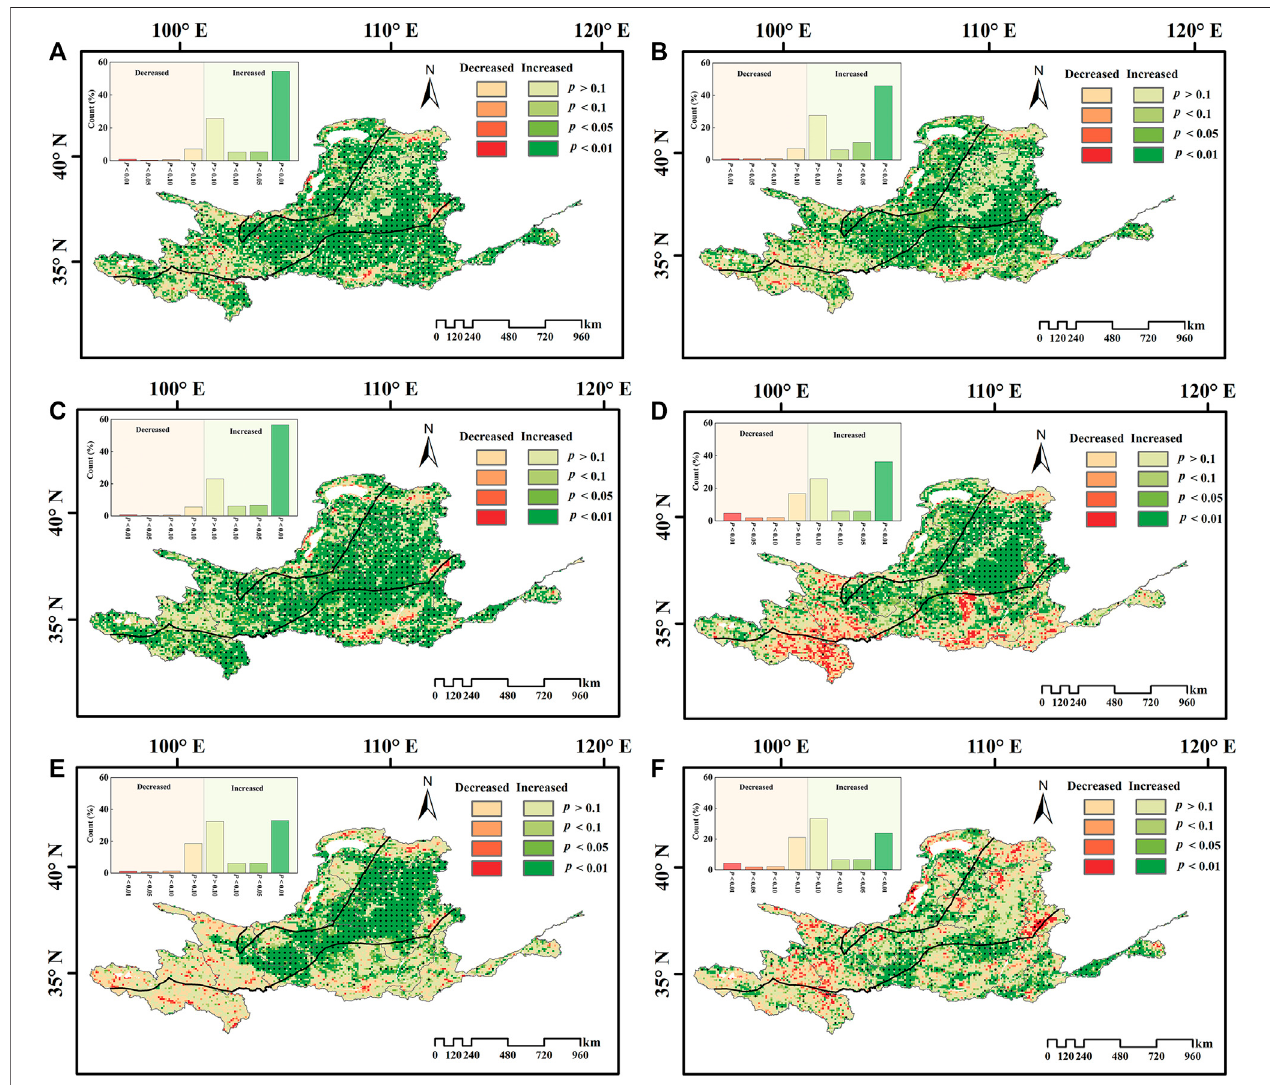
FIGURE 5 | Spatial distribution of NDVI trends in the YellowRiver Basin in (A) annual, (B) growing season, (C) spring, (D) summer, (E) autumn, and (F) winter. The histogram at the top left of the fi gure counted the area proportion for each signi fi cance level (%).